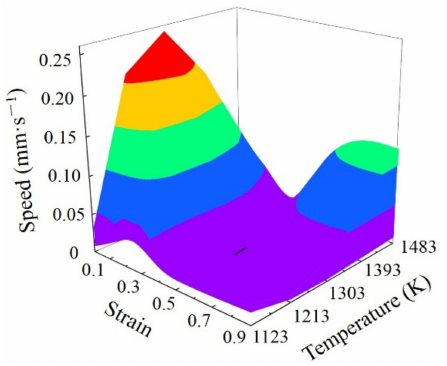
Figure 20. The 3D response surface of the speed-loading